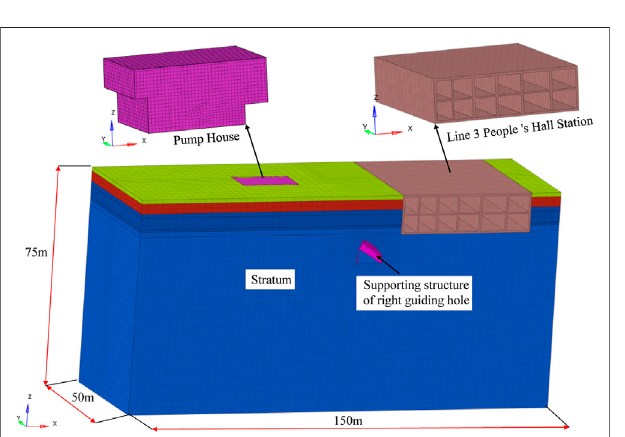
FIGURE 5 | Cut hole layout diagram (unit: cm).